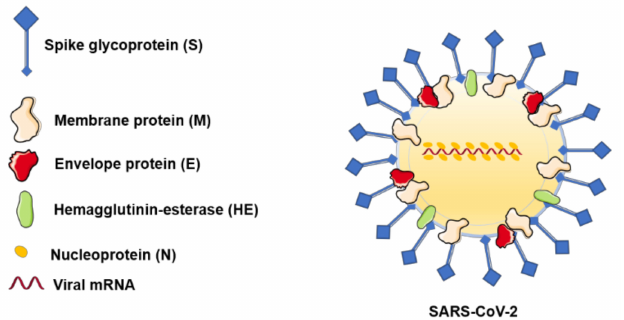
Figure 2. Severe acute respiratory syndrome coronavirus 2 (SARS-CoV-2) structure. This image